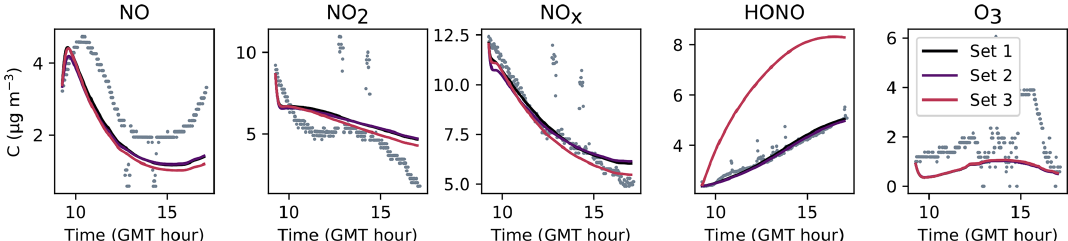
Figure 9. Simulation of Experiment 3 for the three sets of parameters. The dots denote the experimental records. The concentrations simulated in the sunlit box (solid lines) and the concentrations simulated in the shaded box (dashed lines) are